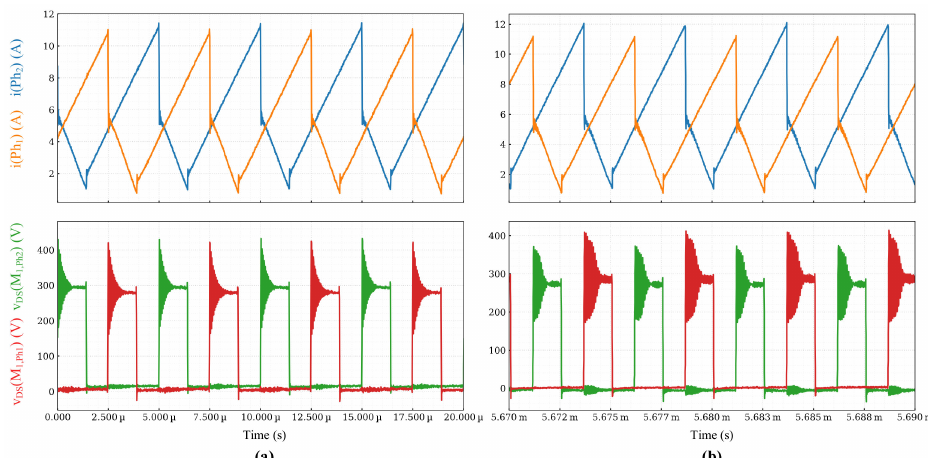
Figure 5. Converter waveforms: ( a ) SiC switch converter (SCT3120ALHR). Upper waveform: In orange current i(Ph 1 ) (2 A/div); in blue i(Ph 2 ) (2 A/div). Lower waveform: In green V DS (M 1,Ph1 ) (100 V/div); in red V DS (M 1,Ph2 ) (100 V/div). Time scale 2.5 µ s/div. ( b ) GaN switch converter (TP65H035WSQA). Upper waveform: In orange current i(Ph 1 ) (2 A/div); in blue i(Ph 2 ) (2 A/div). Lower waveform: In green V DS (M 1,Ph1 ) (100 V/div); in red V DS (M 1,Ph2 ) (100 V/div). Time scale 2.5 µ s/div.